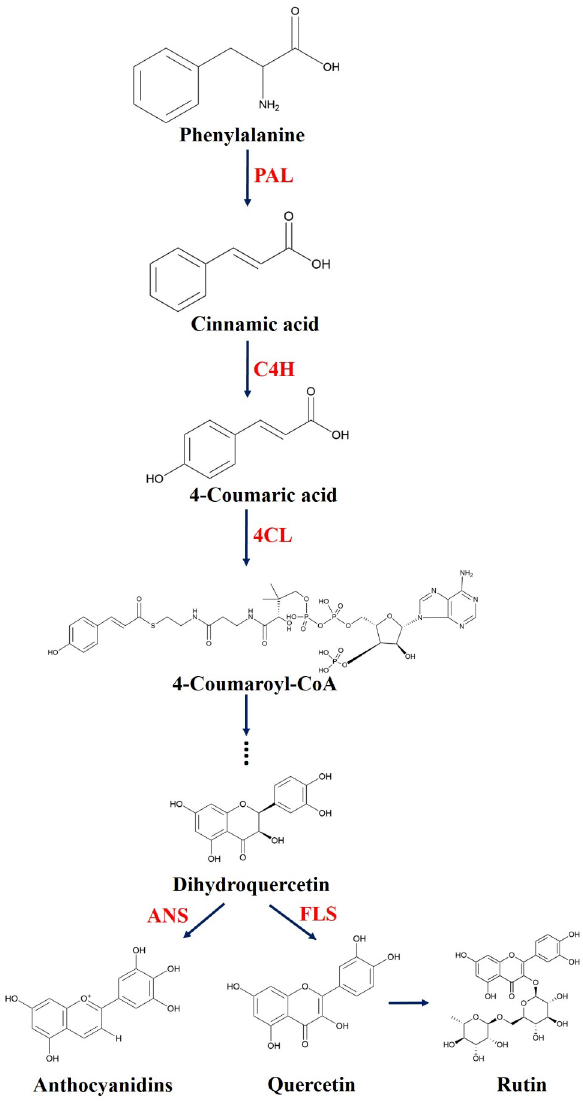
Figure 1. Schematic diagram of flavonoid anabolism in plants [13]. Note: PAL: Phenylalanine ammonia lyase; C4H: Cinnamate -4-hydroxylase; 4CL: 4-coumaric acid coenzyme A ligase; ANS: Anthocyanin synthase; FLS: Plant flavonol synthase.